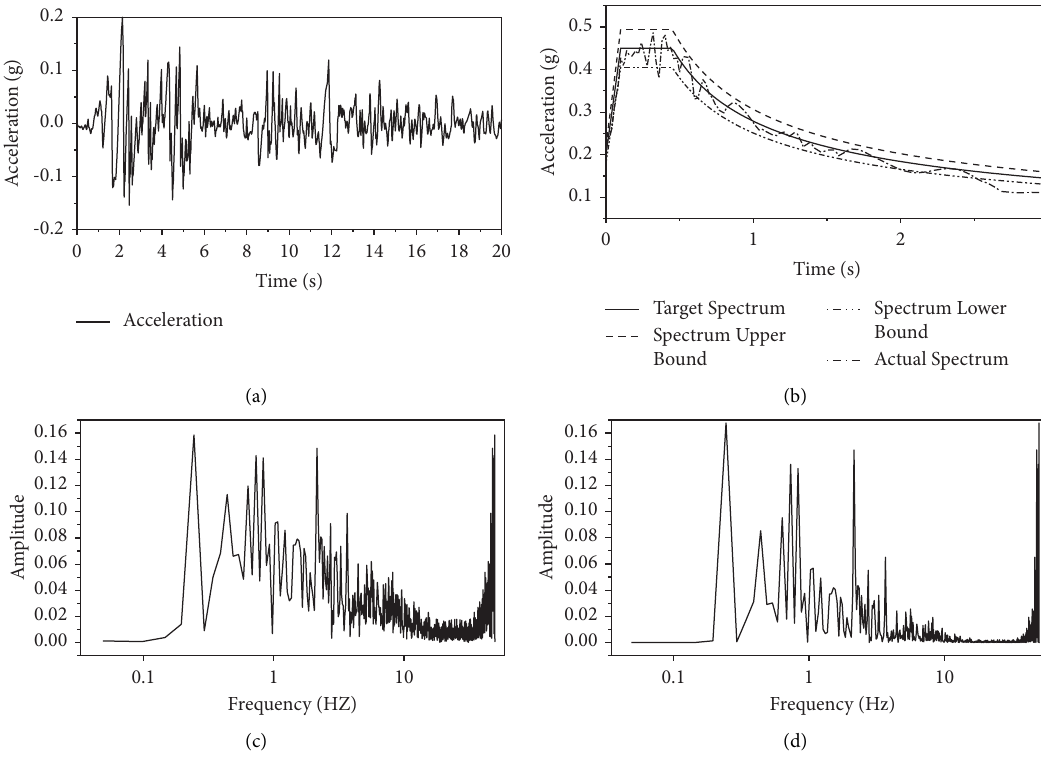
Figure 6: Acceleration time history curve of the artifcially adjusted peak value of el-centro seismic wave. (a) Acceleration time history curve of el-centro wave. (b) Comparison of el-centro wave response spectrum and design reaction spectrum. (c) El-Centro wave Fourier spectrum. (d) El-Centro wave power spectrum.